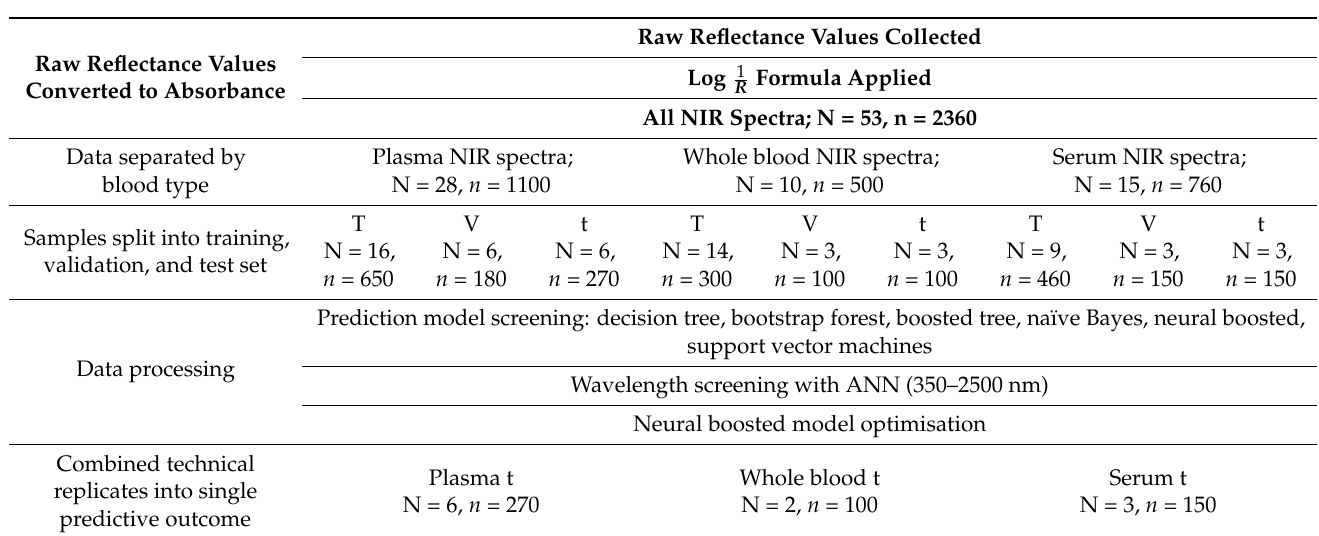
Table 1. The flow of information from data collection to analysis, including the number of samples used for training, validation, and testing models. N refers to the number of biological replicates and n refers to the total number of NIR spectra (technical replicates of the biological replicates) collected/analysed for each data set. The training, validation and test sets were split according to biological replicates. At the model screening step, machine learning techniques, such as decision tree, bootstrap forest, boosted tree, naïve Bayes, neural boosted, support vector machines were applied. T represents training set, V represents validation set and t represents test